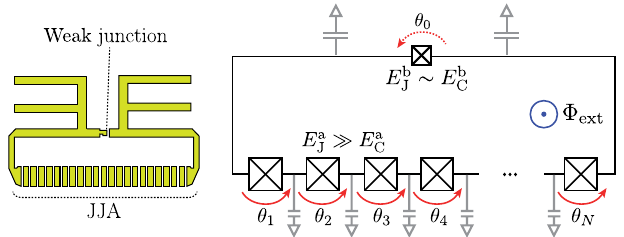
FIG. 1. Circuit of the fluxonium device: a Josephson-junction array (JJA) of nominally identical junctions with Josephson and charging energy E a energy E a J (Josephson and charging energy E b